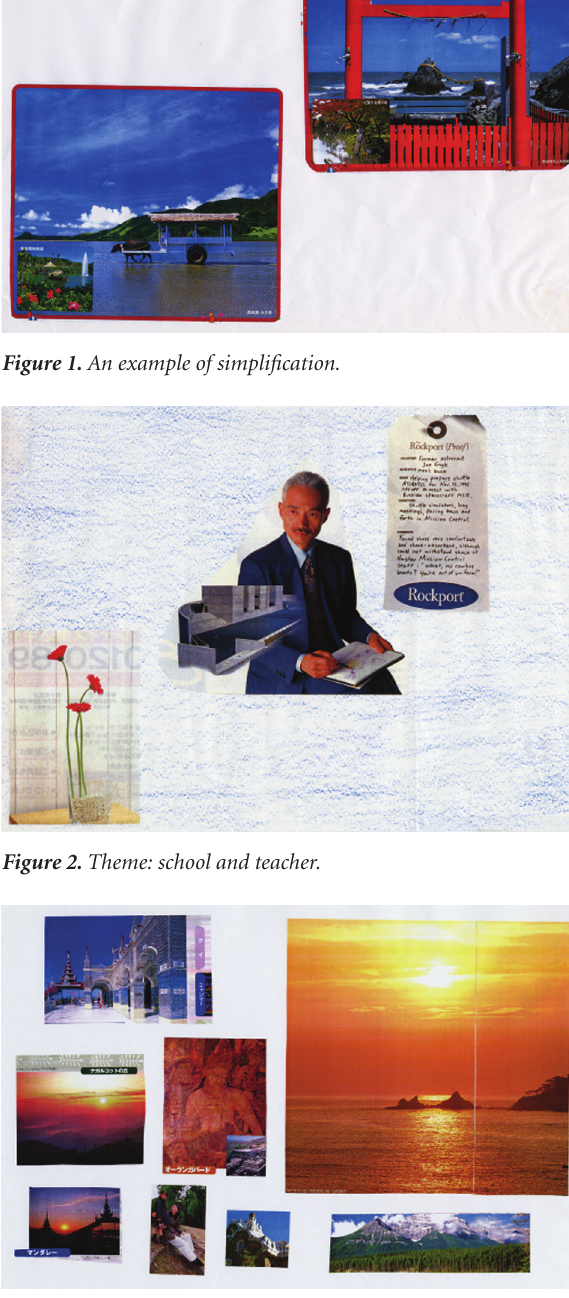
Figure 3. Spiritual